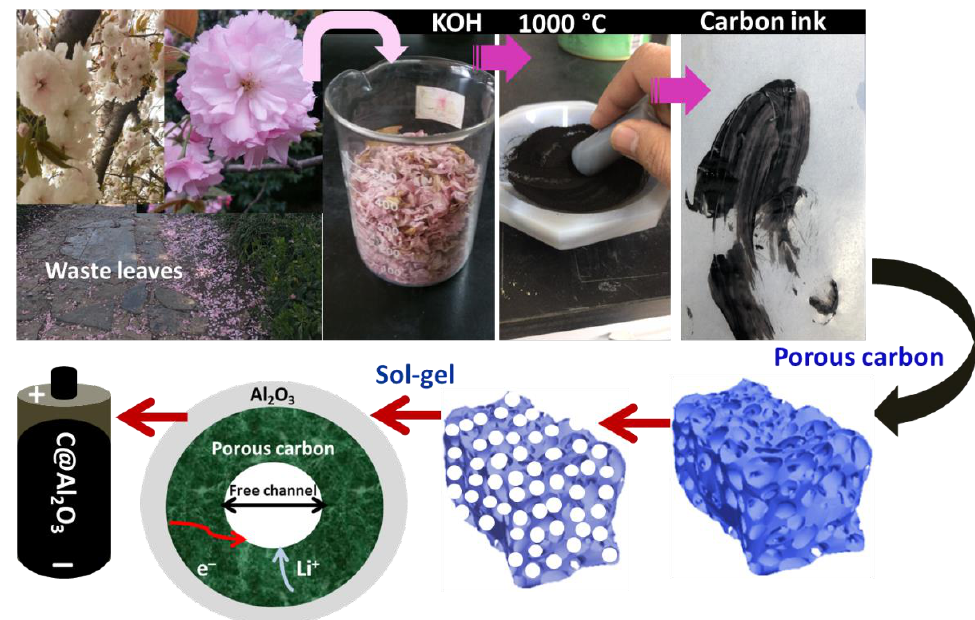
Figure 1. Schematic illustrations of carbon activation and C@Al 2 O 3 composite preparation process.